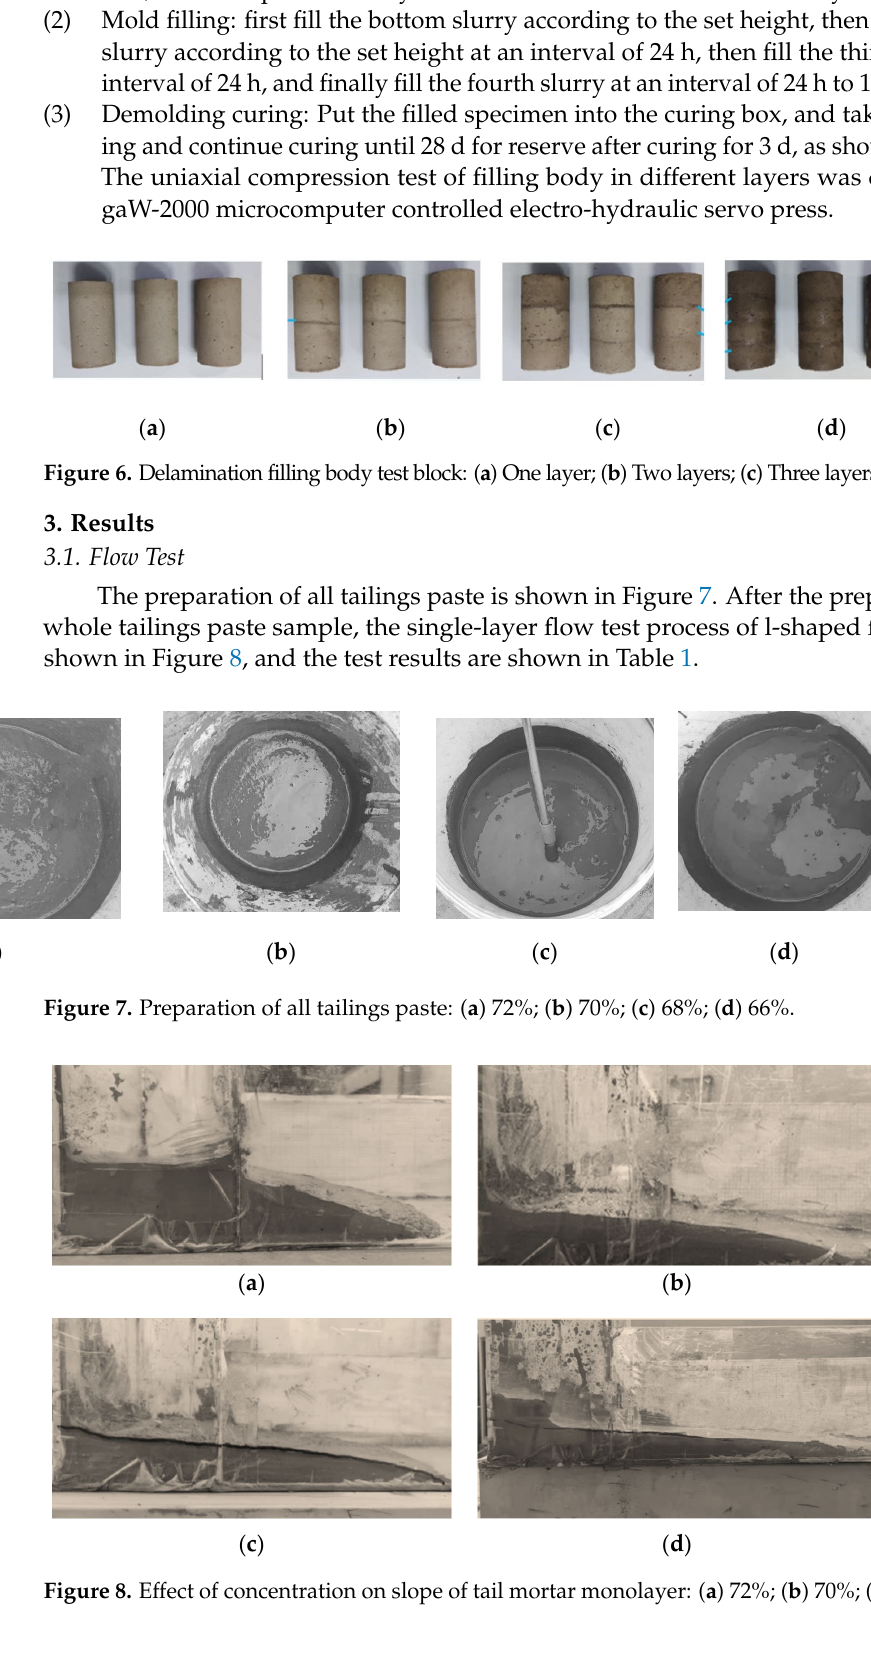
Figure 8. Effect of concentration on slope of tail mortar monolayer: ( a ) 72%; ( b ) 70%; ( c ) 68%; ( d )